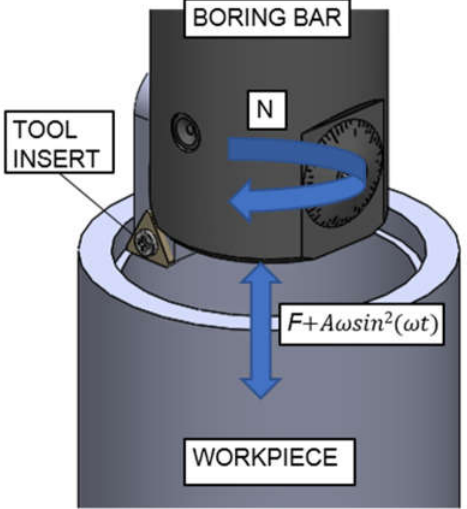
Figure 1. Sketch of LFAB according to commercial function.